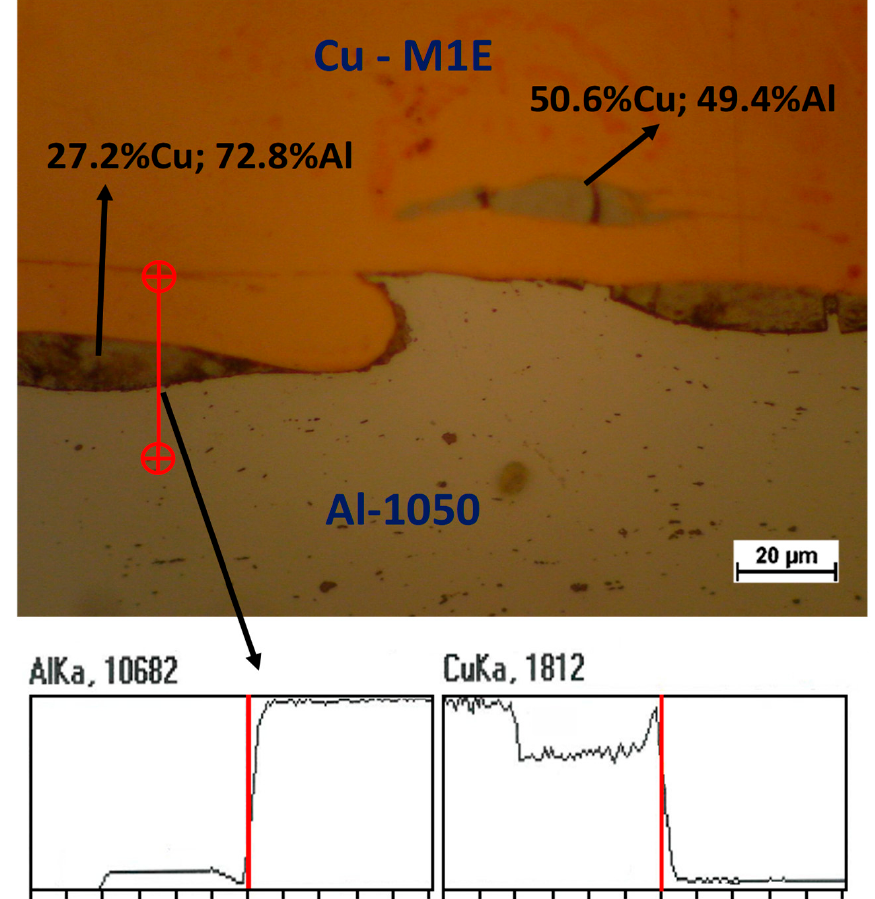
Figure 3. Example microstructure of the CuAl 2 phase, obtained as a result of heat treatment, with markedly different measured chemical composition.